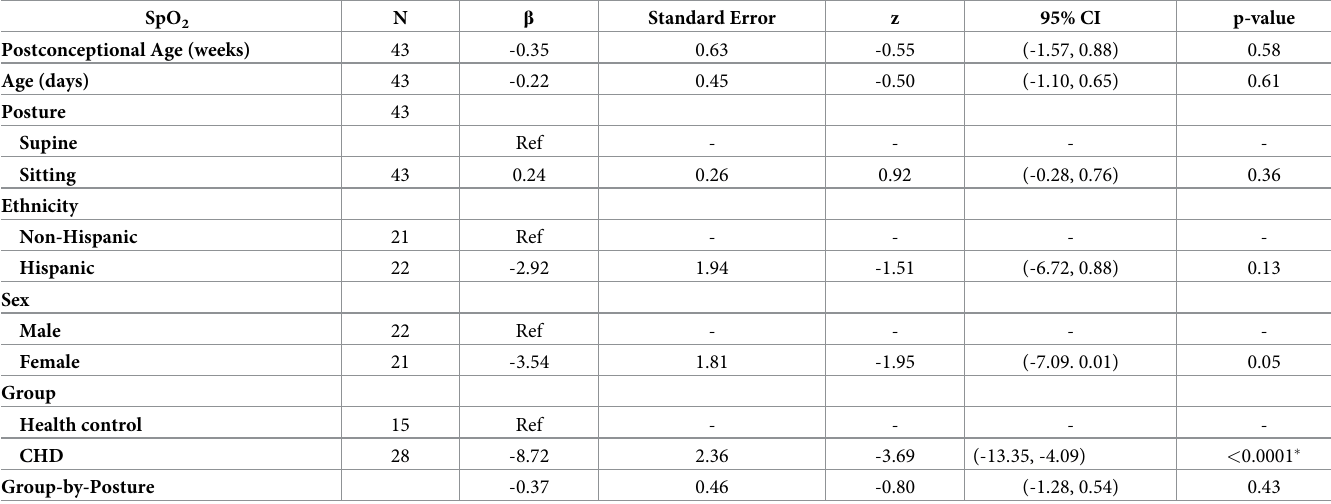
A generalized estimating equation assessed the associations of group (CHD, healthy control) and posture with SpO 2 values (the dependent variable). Covariates were postconceptional age, sex, and ethnicity. The group-by-posture interaction tested SpO 2 ’s influence on cerebrovascular stability. CHD = congenital heart disease; rcSO 2 = regional cerebral oxygen saturation; SpO 2 = preductal peripheral oxygen saturation. � p <